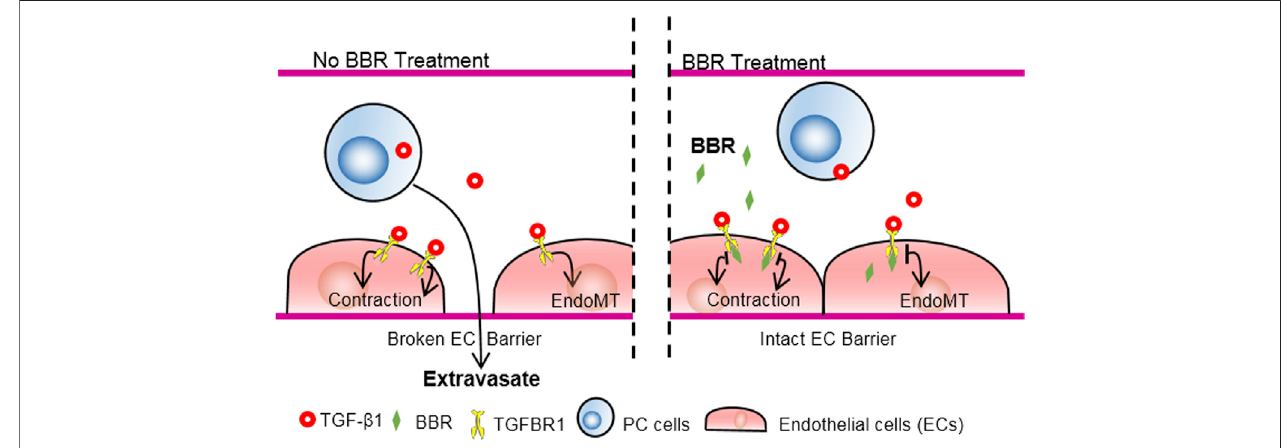
FIGURE 7 | Schematic illustration of the anti-metastatic effect of BBR via TGFBR1 inhibition. PC cell-derived TGF- β 1 disrupts the EC barrier through stimulating TGFBR1, a receptor for TGF- β 1, and promotes PC metastasis. BBR interacts with the intracellular portion of TGFBR1, inhibits the enzymatic activities of TGFBR1, improves EC barrier, and suppresses PC